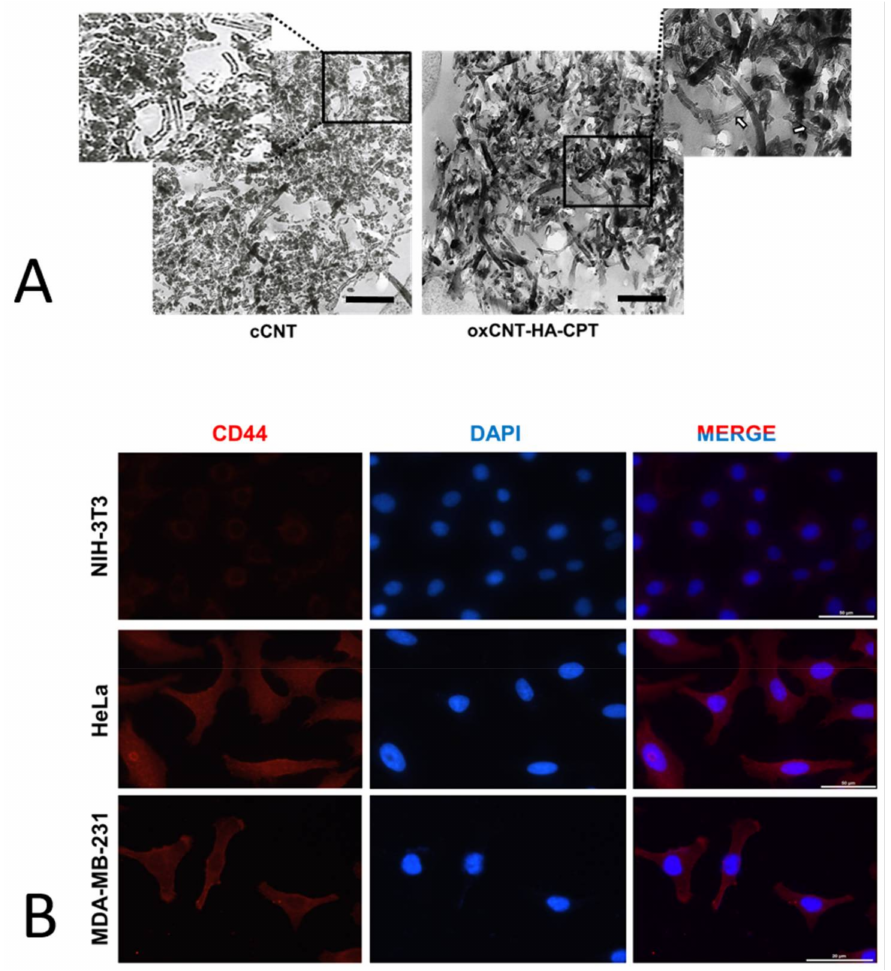
Figure 1. ( A ). Transmission electron micrographs of commercial-grade carbon nanotubes (cCNTs). Notice the disorganization and agglomeration of the nanotubes. In the oxidized and functionalized CNTs loaded with CPT (oxCNTs–HA-CPT), observe the greater scattering, increase in the electroden- sity of the walls, and the electrodense spots inside that correspond to the Carboplatin (CPT) (white arrows). Scale = 1.5 µ m. ( B ). Determination of the CD44 receptor in NIH-3T3 (non-tumor cells), HeLa (cervical cancer cells), and MDA-MB-231 (breast cancer cells) using the indirect immunofluorescence technique. Note the increased positivity for the CD44 receptor in tumor cells. Scale = 50 µ